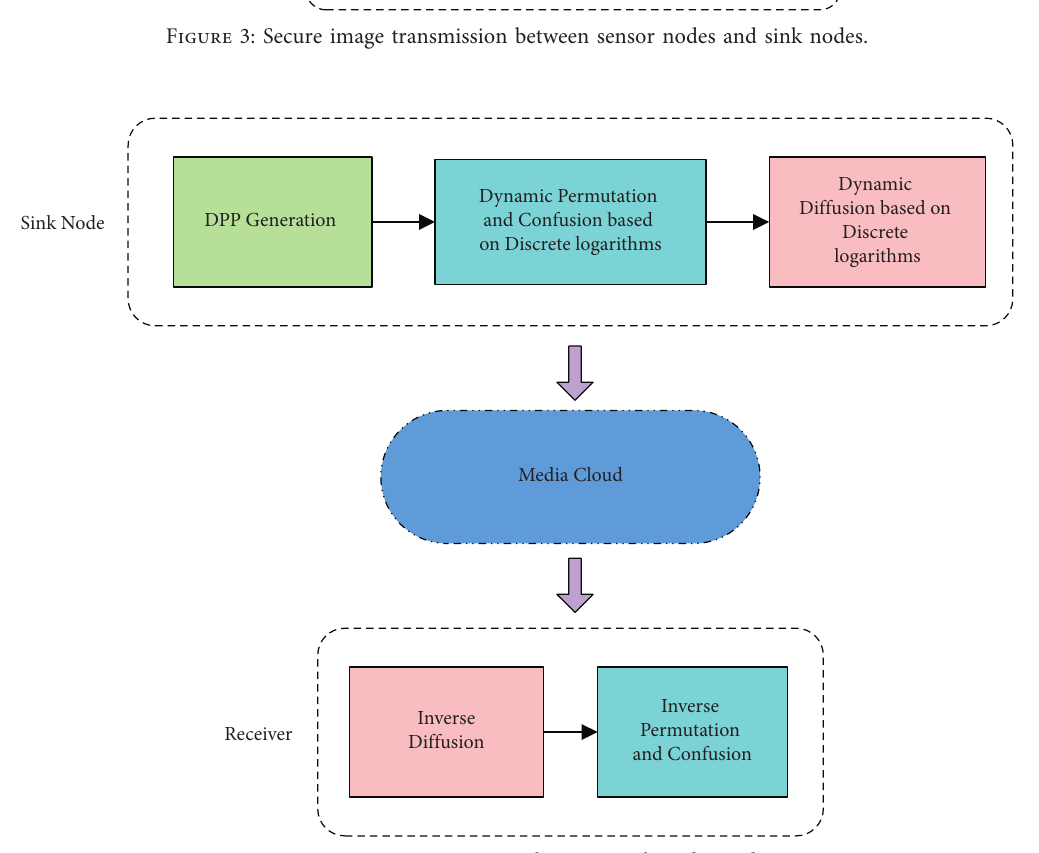
Figure 4: Secure image transmission between sink nodes and